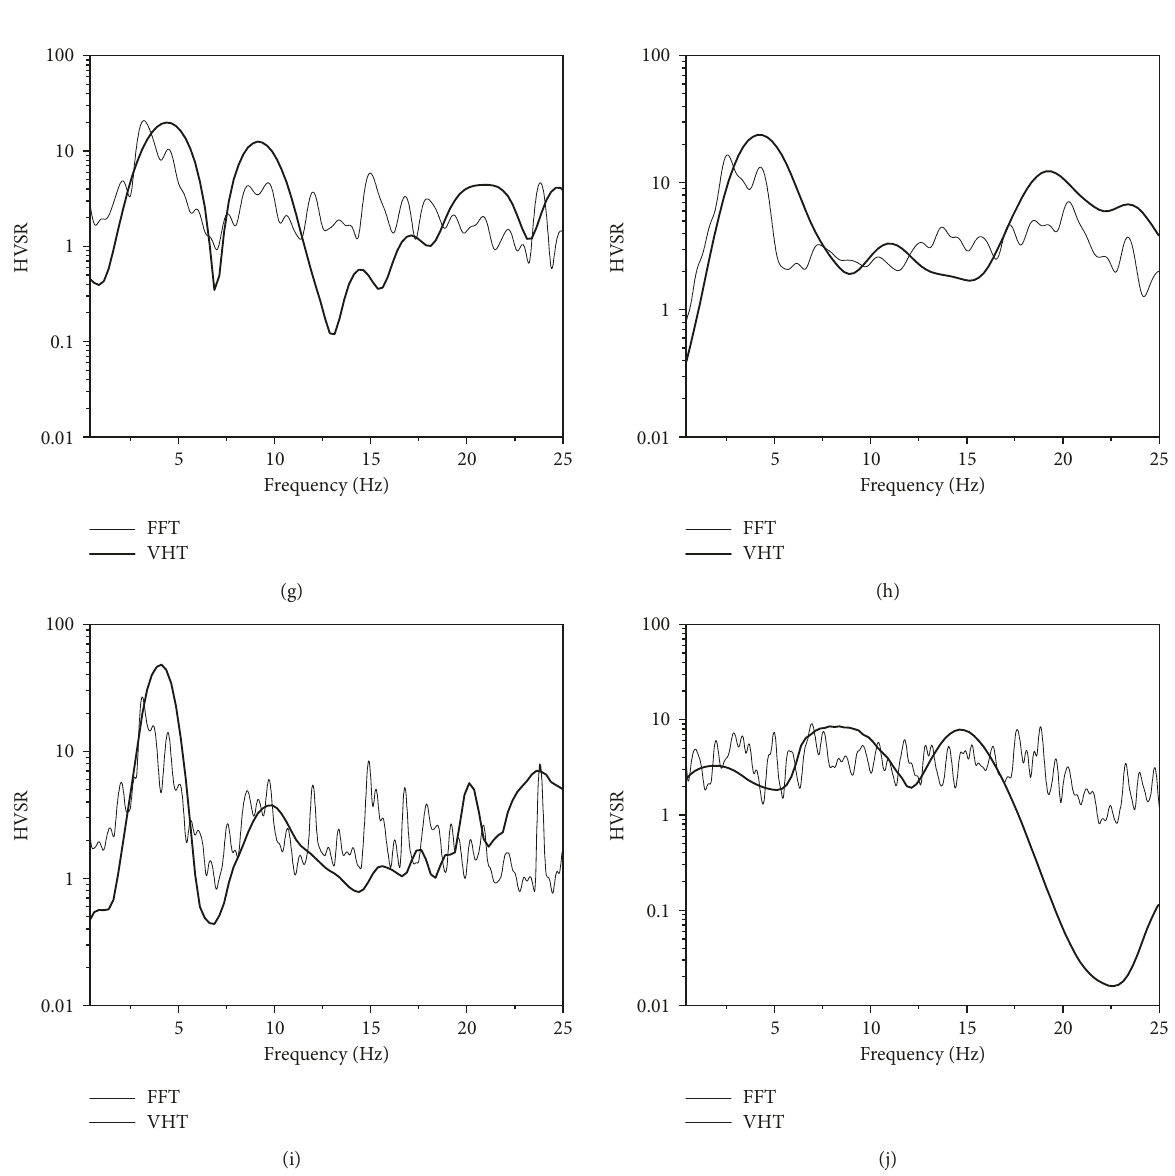
Figure 18: HVSRs based on FFTand VHTof the two events. (a) 53YBX. (b) L2203. (c) L2201. (d) L3003. (e) L2202. (f) 53LLT. (g) 53QQC. (h) 53LDC. (i) 53QJX. (j)